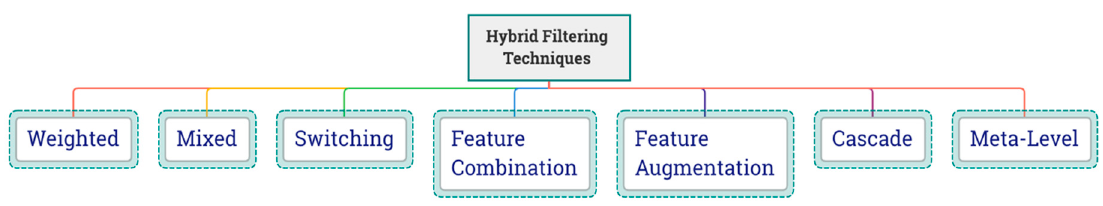
Figure 1. Hybrid filtering strategies.